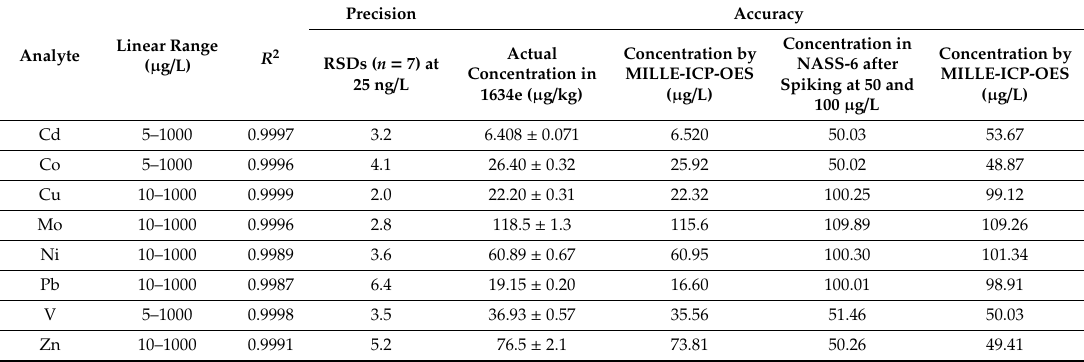
Table 3. Analytical figures of merit of MILLE-ICP-OES (Inductively Coupled Plasma-Optical Emission Spectroscopy).